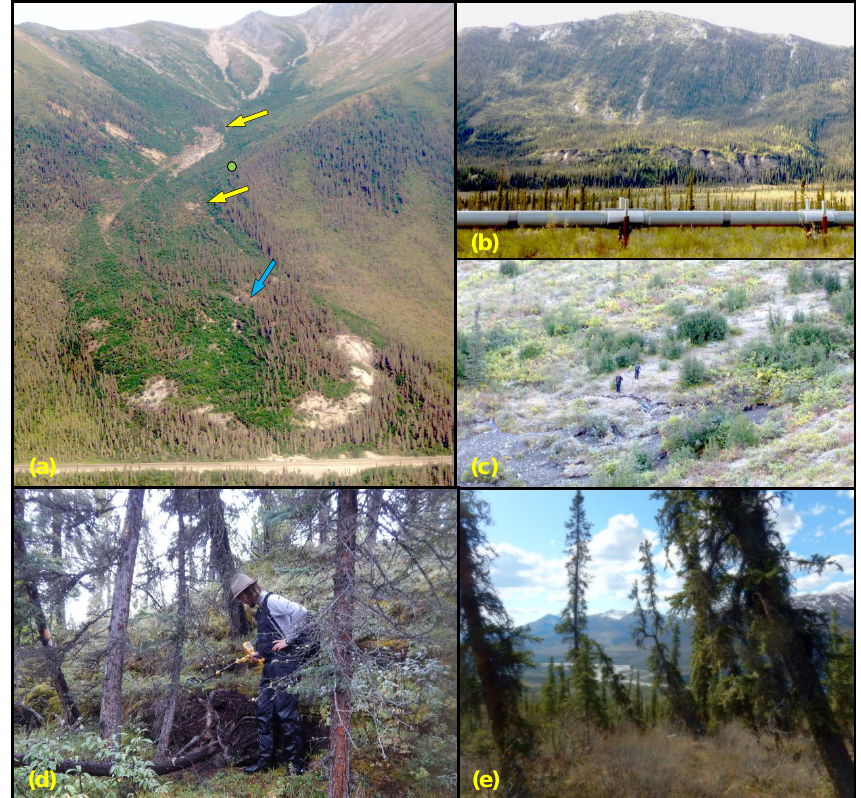
Figure 2. Typical FDL appearance, lobe, and catchment features. (a) FDL-A, originating from a cirque-like catchment; the Dalton Highway is in the foreground (photograph taken in June 2013). Yellow arrows indicate locations of two retrogressive thaw slumps (RTSs), the blue arrow indicates the location of the 2012 instrumented borehole, and the green dot is the location of the sampled organic layer. (b) FDL at the base of a slope outside of the AOI that may have formed from a paleolandslide deposit. The Trans Alaska Pipeline is in the foreground. (c) FDL-11 catchment, showing typical vegetation and recent scarp; two people stand above the scarp for scale. (d) Riser of smaller surface lobe on FDL-C. (e) Trees near the right flank lean progressively towards the center of